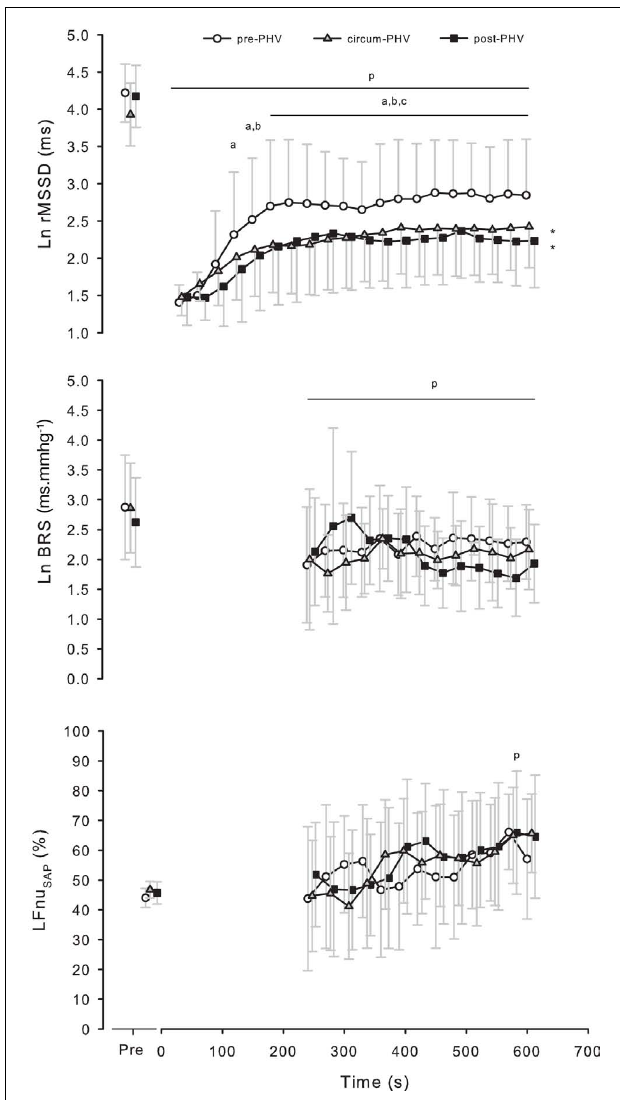
FIGURE 2 |Values are means ± SD for the natural logarithm of the square root of the mean of the sum of the squares of differences between adjacent normal R–R intervals (Ln rMSSD), baroreceptor reflex sensitivity (Ln BRS) and normalized low frequency power of systolic arterial pressure variability (LFnu SAP ) measured on successive 30s segments before and after incremental exercise in pre- (pre-PHV), circum- (circum-PHV), and post-(post-PHV) peak height velocity soccer players. *, Significant difference vs. pre-PHV ( P < 0.05); p, significant difference vs. Pre ( P < 0.05); a, significant difference vs. Post 30 ( P < 0.05); b, significant difference vs. Post 60 ( P < 0.05); c, significant difference vs. Post 90 ( P <